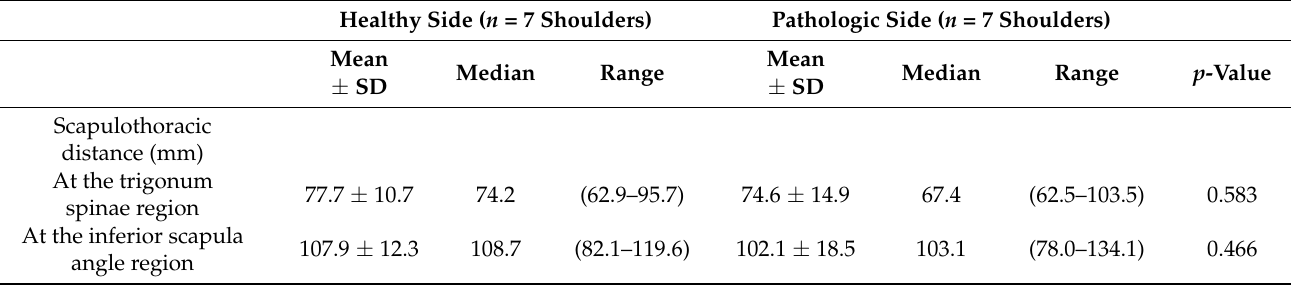
Table 1. Scapulothoracic